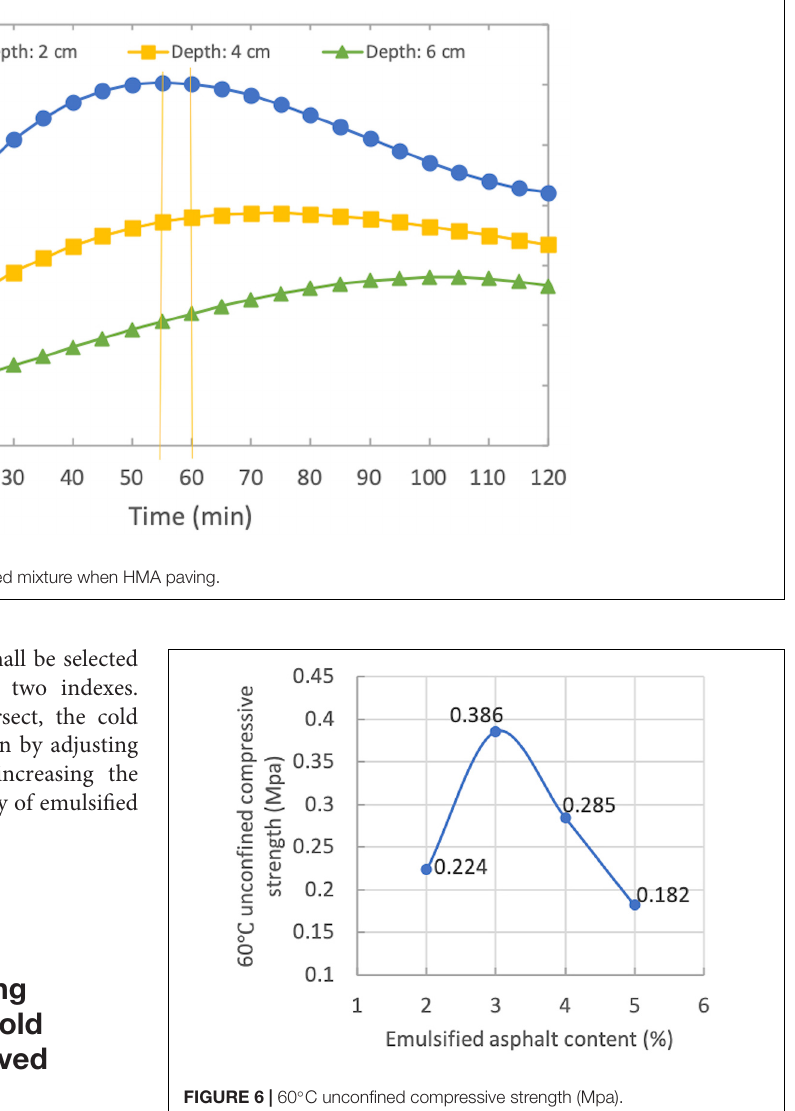
FIGURE 6 | 60 ◦ C unconfined compressive strength